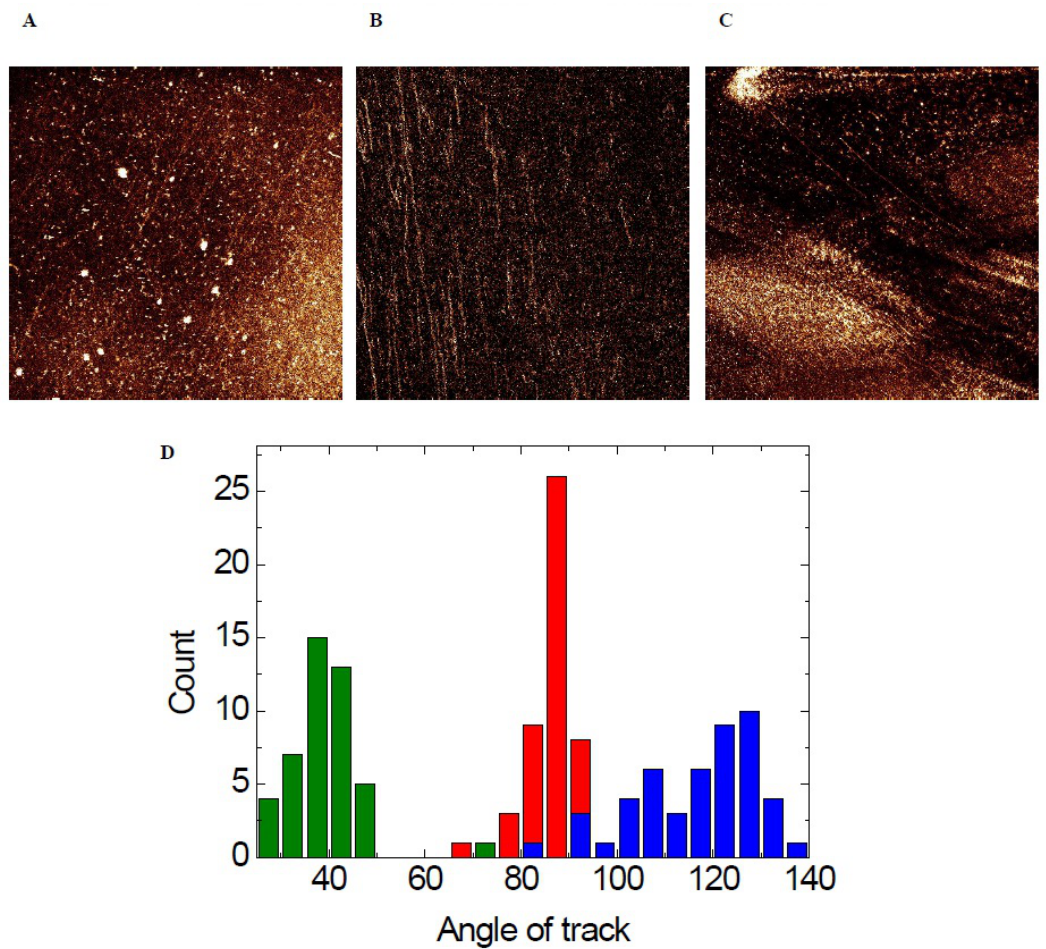
Figure 5: A-C Luminescence image (pulsed (140 fs) excitation at 700 nm. The polarization of the microscope laser beam was changed with a 1/2 wavelength plate. D The angle of the tracks was then measured against the horizontal. The tracks at about 90 ∘ (red) are with the system polarization while the tracks under about 40 ∘ (green) and 130 ∘ (blue) are obtained by rotating the polarization of 45 ∘ .